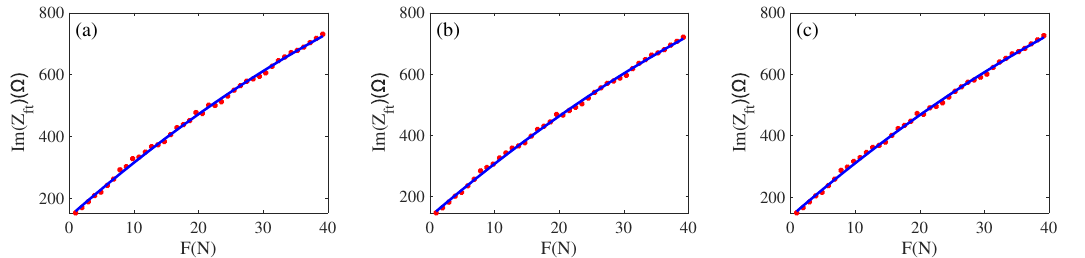
Figure 15. ( a ) Load and imaginary part by an inscribed circle; ( b ) Load and imaginary part by a circumcircle; ( c ) Load and imaginary part by average.